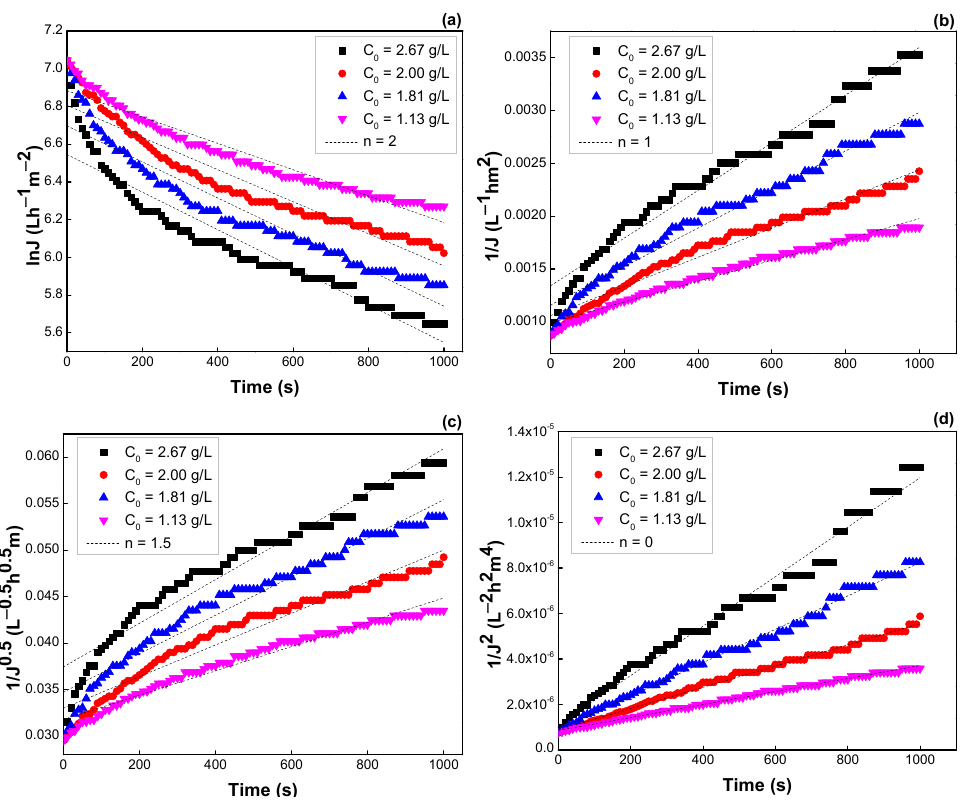
Figure 10. Effect of surfactin concentration on the flux predicted by the Hermia model: ( a ) n = 2, ( b ) n = 1, ( c ) n = 1.5, and ( d ) n = 0 (see Table 3). Table 4. R 2 values and K constants in the Hermia model at different surfactin concentrations. C 0